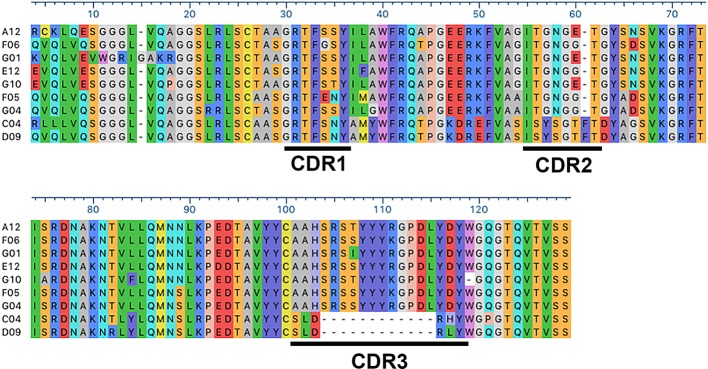
Comparison of the predicted structures of the constructs. The three-dimensional structure of scFv62 as a monomer, its assembly as a functional trimer, and the three-dimensional (3-D) structures of scFv62-scTRAIL and VHH-D9-scTRAIL are depicted with the different moieties in different colors (blue, green and magenta for scFv62, red for VHH and light brown for TRAIL). The TRAIL trimer structure corresponds to PDB ID 1dg6 (Hymowitz et al., 2000). The structures of scFv62 and VHH-D9 have been modelled using AbodyBuilder (Leem et al., 2016). The PDB files can be found in Supplementary Information.